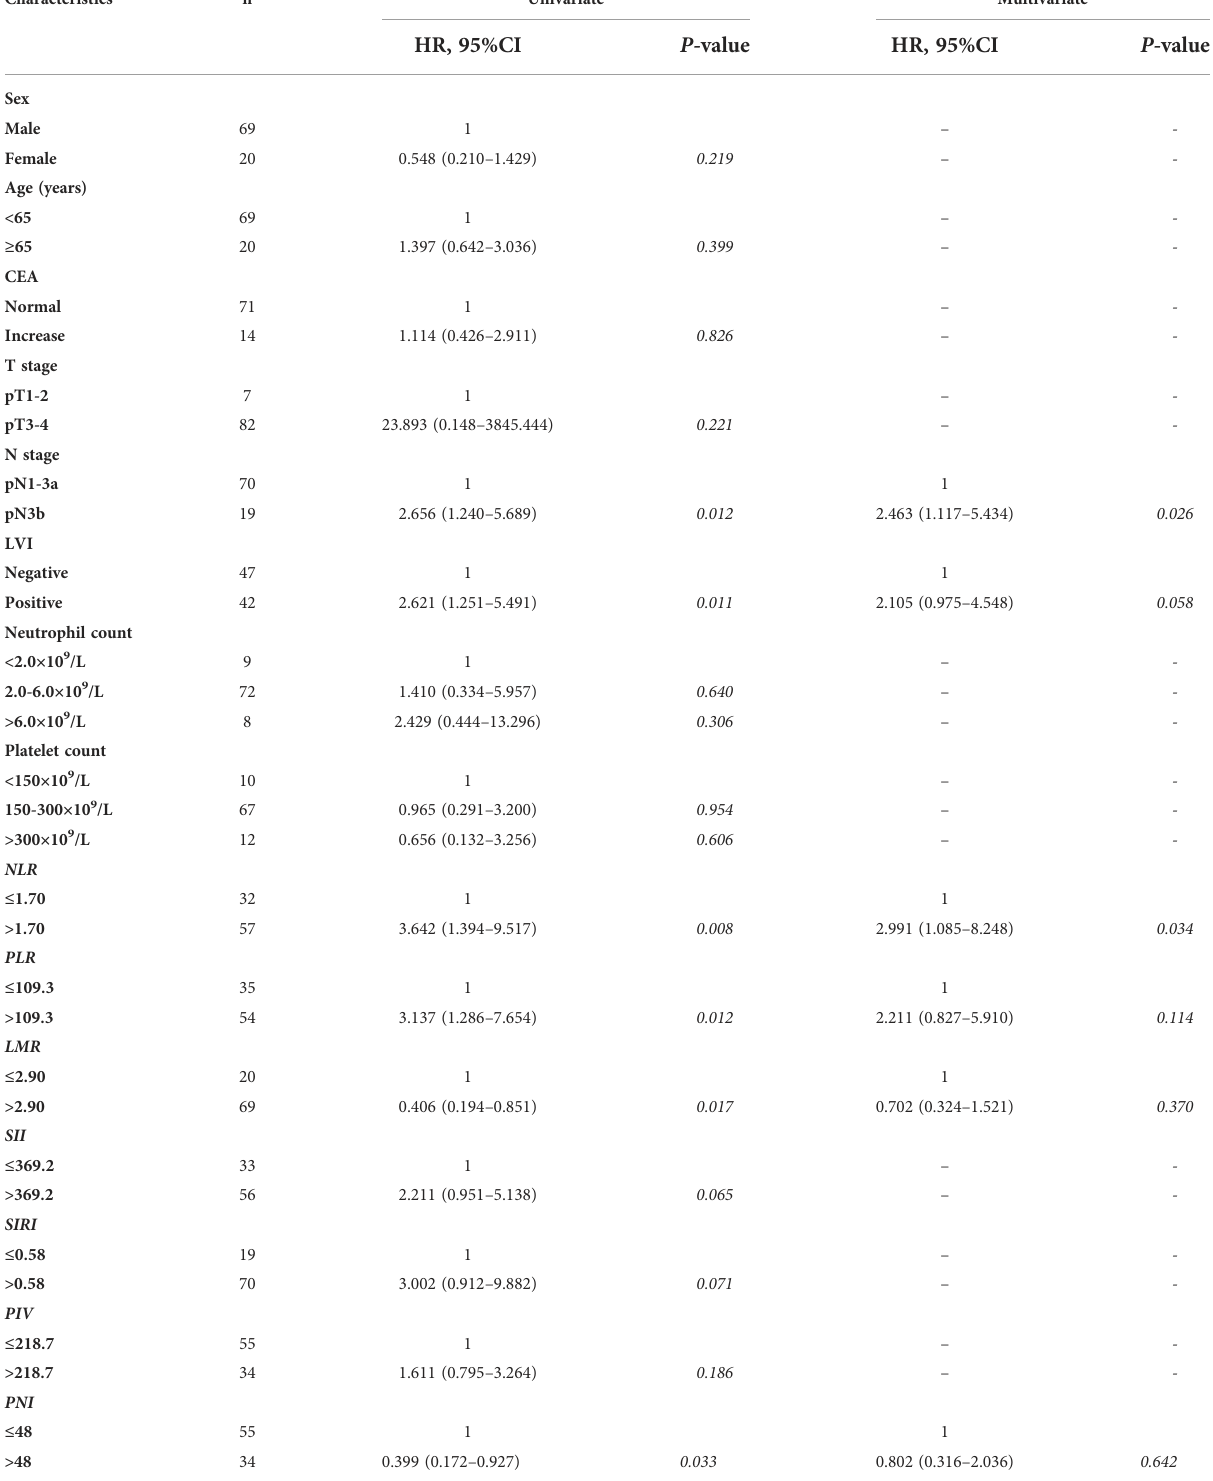
TABLE 2 Univariate and multivariate analysis for 3-year DFS in patients with gastric cancer treated with D2 gastrectomy and chemoradiotherapy.